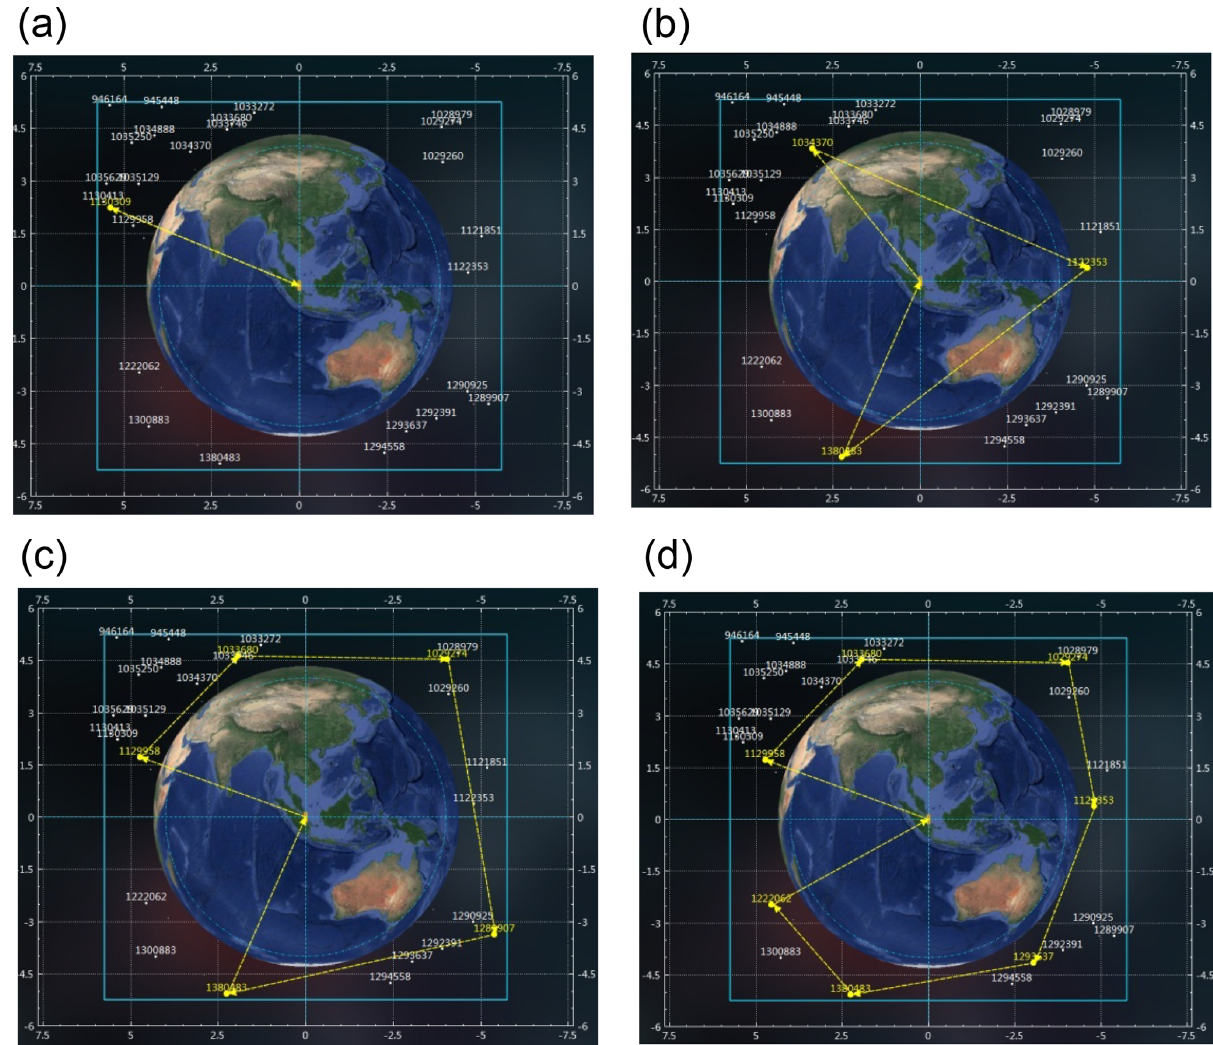
Figure 9. AGRI star selection results – without the sun: (a) the result of choosing one star, (b) the result of choosing three stars, (c) the result of choosing five stars and (d) the result of choosing seven